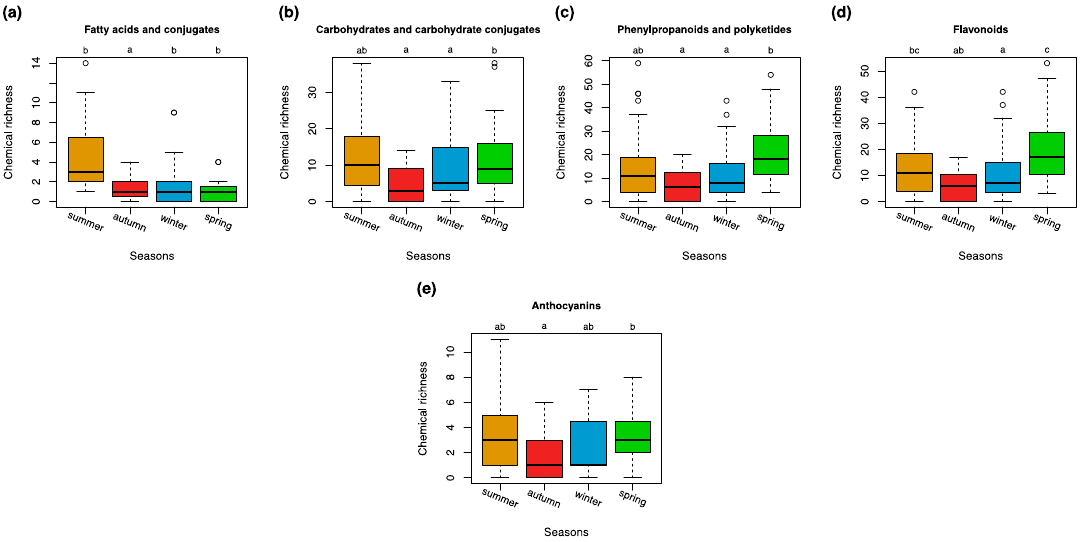
Figure 5. Seasonal variation in the richness of chemical entities (features) within the chosen chemical classes of ( a ) fatty acids and conjugates, ( b ) carbohydrates and carbohydrate conjugates, ( c ) phenylpropanoids and polyketides, ( d ) flavonoids, and ( e ) anthocyanins. Differences among groups (letters on the top of the plot) are based on the Tukey HSD post hoc test on a one-way ANOVA. Different letters show significant differences ( p < 0.05). n = 27 for each season.